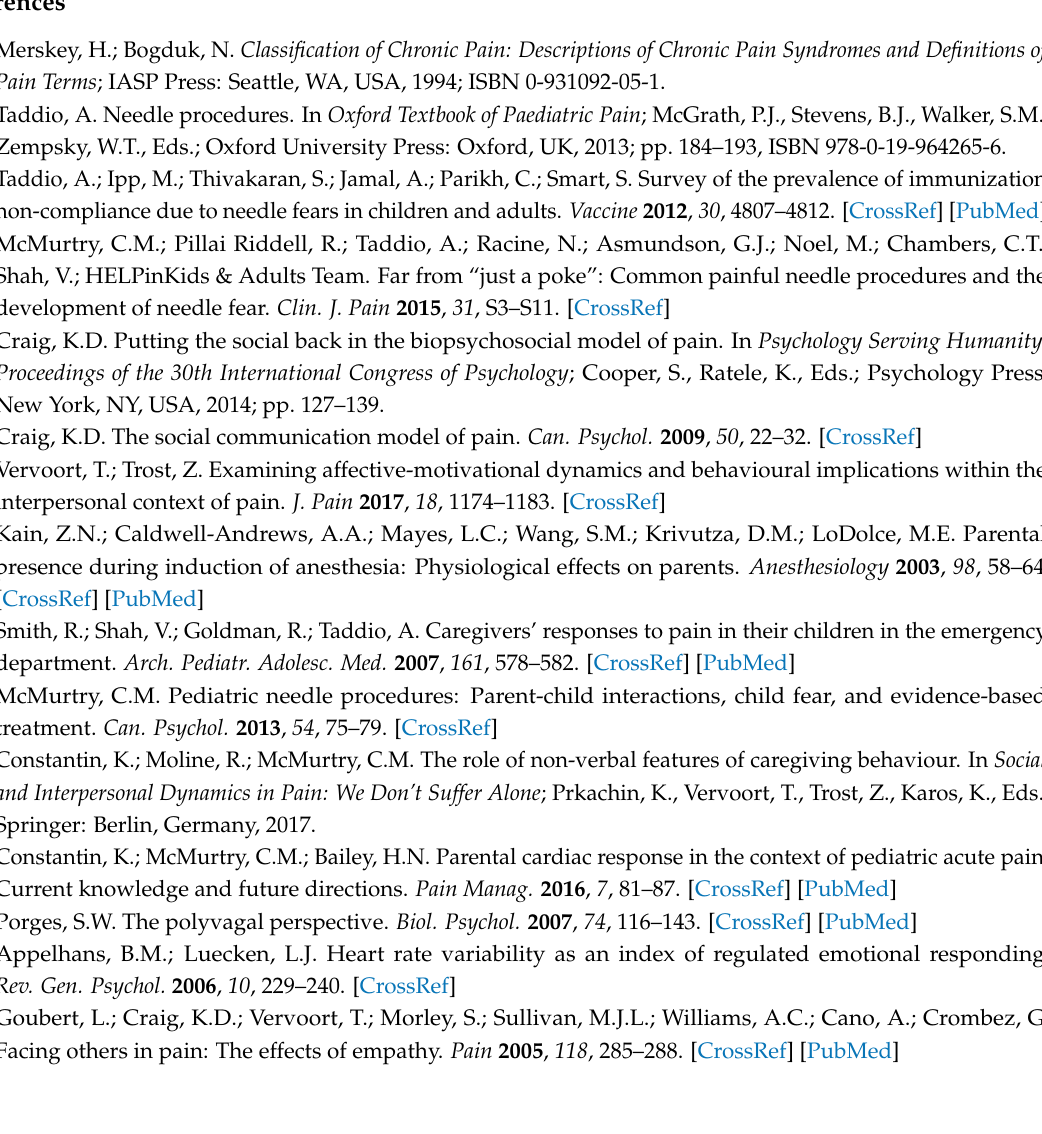
Table S1. Bivariate Correlations Between Children’s Typical Response to Pain and Parent Heart Rate (HR) ( N = 25). Table S2. Bivariate Correlations Between Children’s Typical Response to Needle Pain and Parent Heart Rate Variability (HRV) ( N =